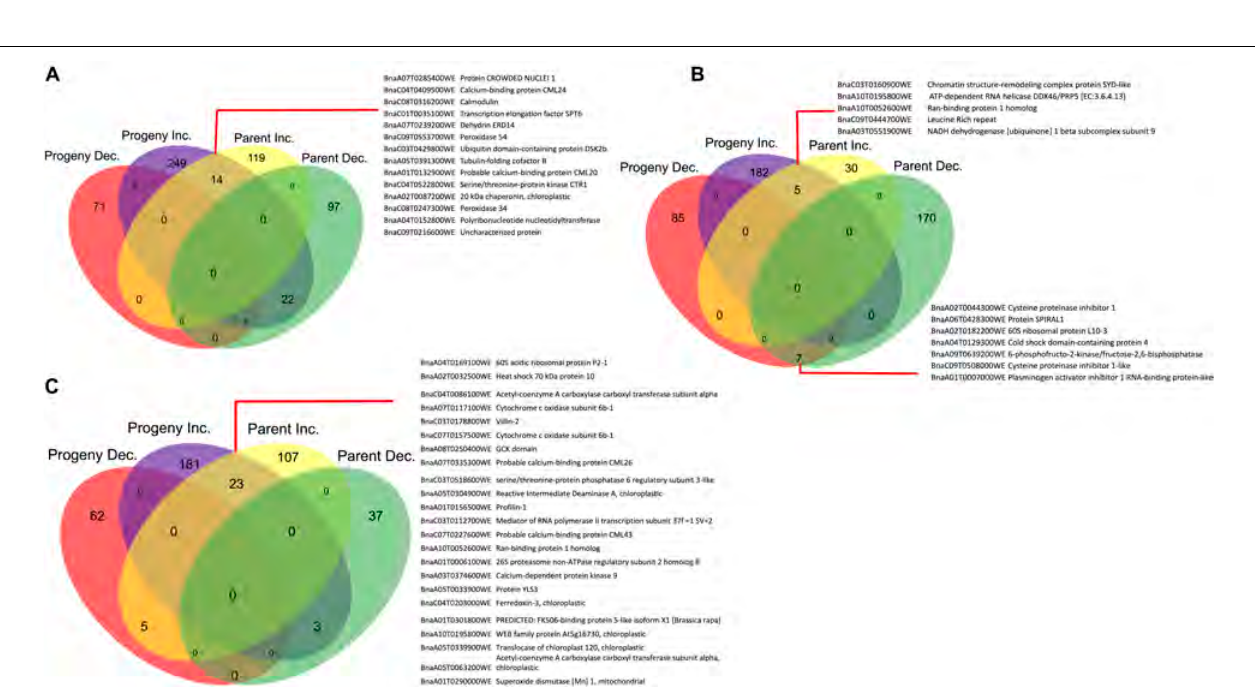
FIGURE 6 | Differentially accumulated proteins (DAP) between clubroot resistant (CR) and susceptible (CS) inoculated, CR/CS progeny and CR/CS parent lines in the progeny and parental lines. The numeric values indicate the number of proteins that were significantly changing in abundance ( q -value < 0.05) in protein abundance. (A) 7 DPI, (B) 14 DPI, (C) 21 DPI. Inc and Dec represent Increase and Decrease; respectively.